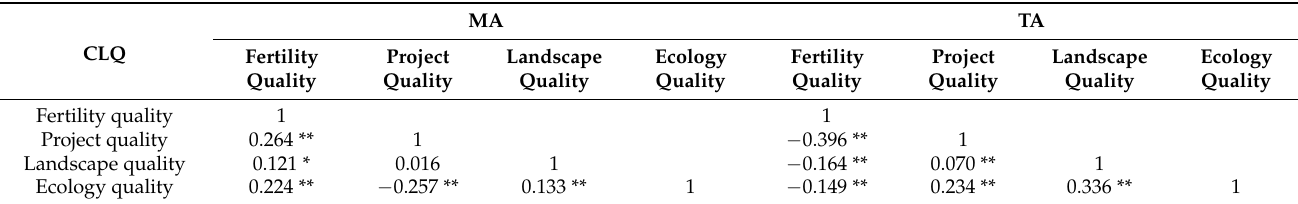
MA TA Fertility Project Landscape Ecology Fertility Project Landscape Ecology Quality Quality Quality Quality Quality Quality Quality Quality